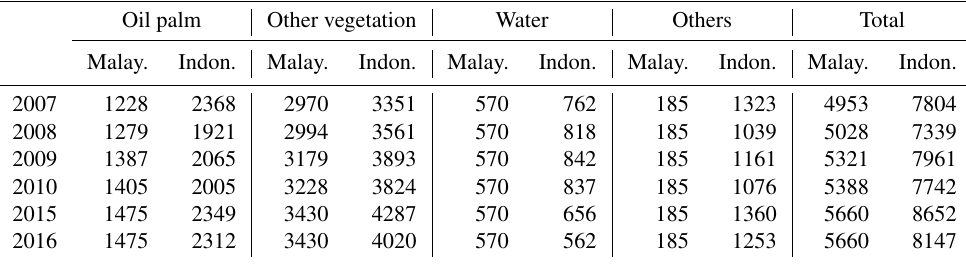
Table 1. The distribution of training data (unit: pixel). Malay.: Malaysia. Indon.: Indonesia. Oil palm Other vegetation Water Others Total Malay. Indon. Malay. Indon. Malay. Indon. Malay. Indon. Malay. Indon. 2970 185 1323 4953 7804